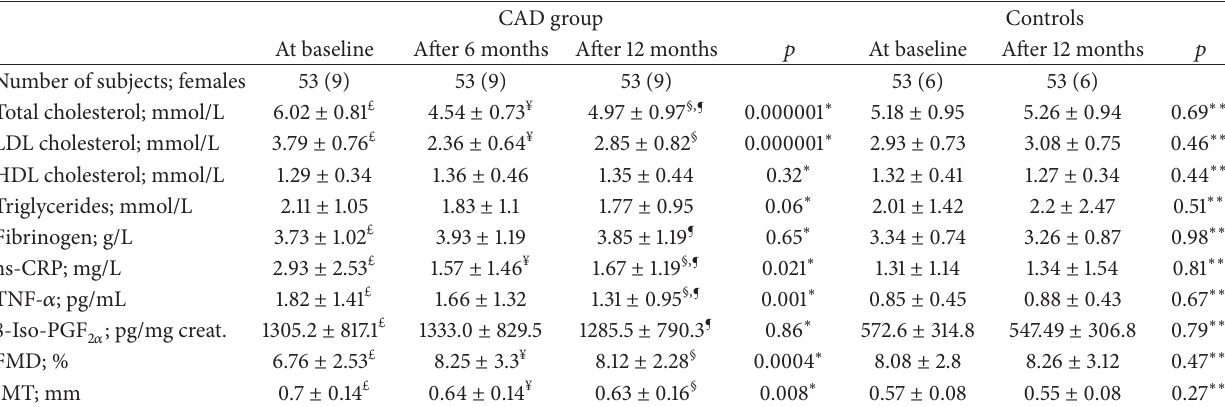
Table 2: Lipid profile, concentrations of selected markers of inflammation, oxidative stress, FMD, and IMT in patients and controls before and after treatment with simvastatin. CAD